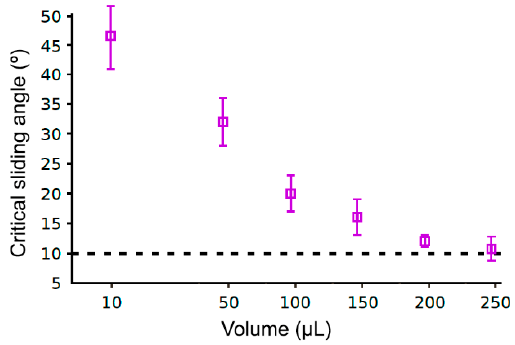
Figure 3. Sliding Angle in a PTFE coating cured at 410 °C (without further surface treatment), for different drop volumes of Milli-Q water (for 5 μ L, we measured SA ≥ 60°).